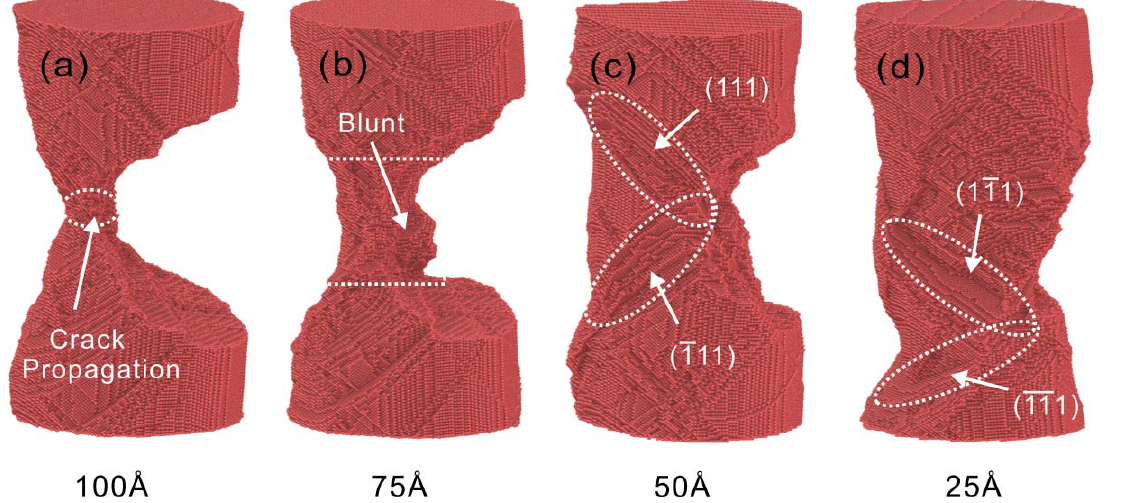
Figure 7. Atomic configuration of four deep cracks at 5 × 10 8 s − 1 strain rate. ( a ) 100 Å, ( b ) 75 Å, ( c ) 50 Å, ( d ) 25Å.